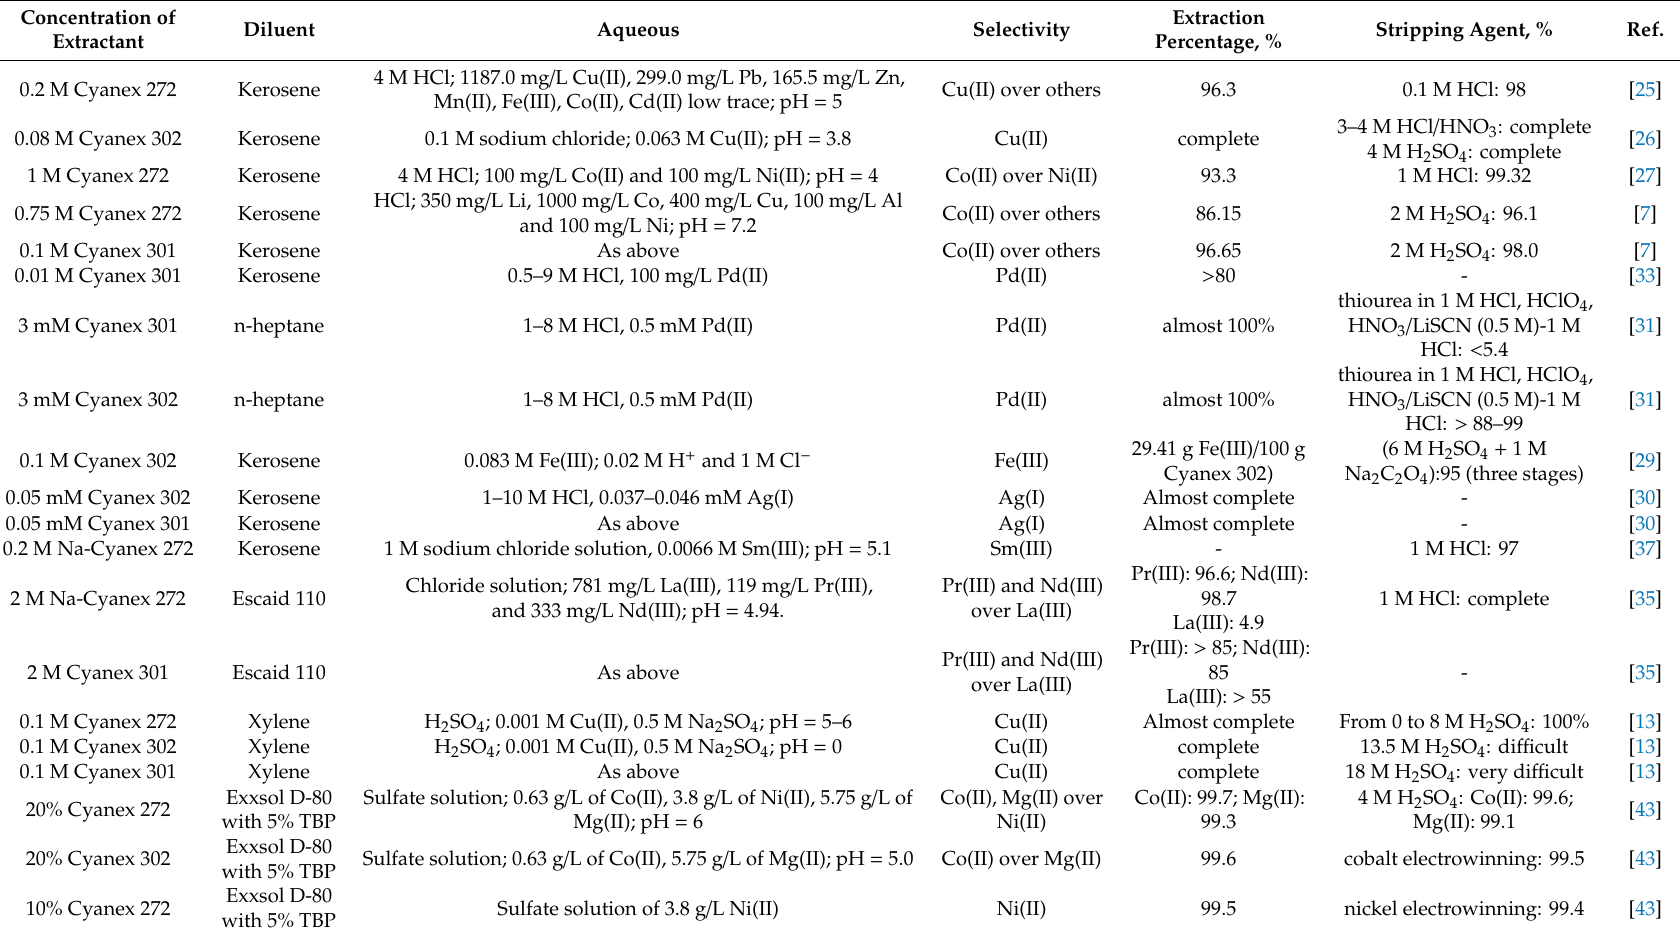
Table 4. Results of the solvent extraction of metal ions from inorganic acidic solution by Cyanex 272 / 302 / 301. Concentration of